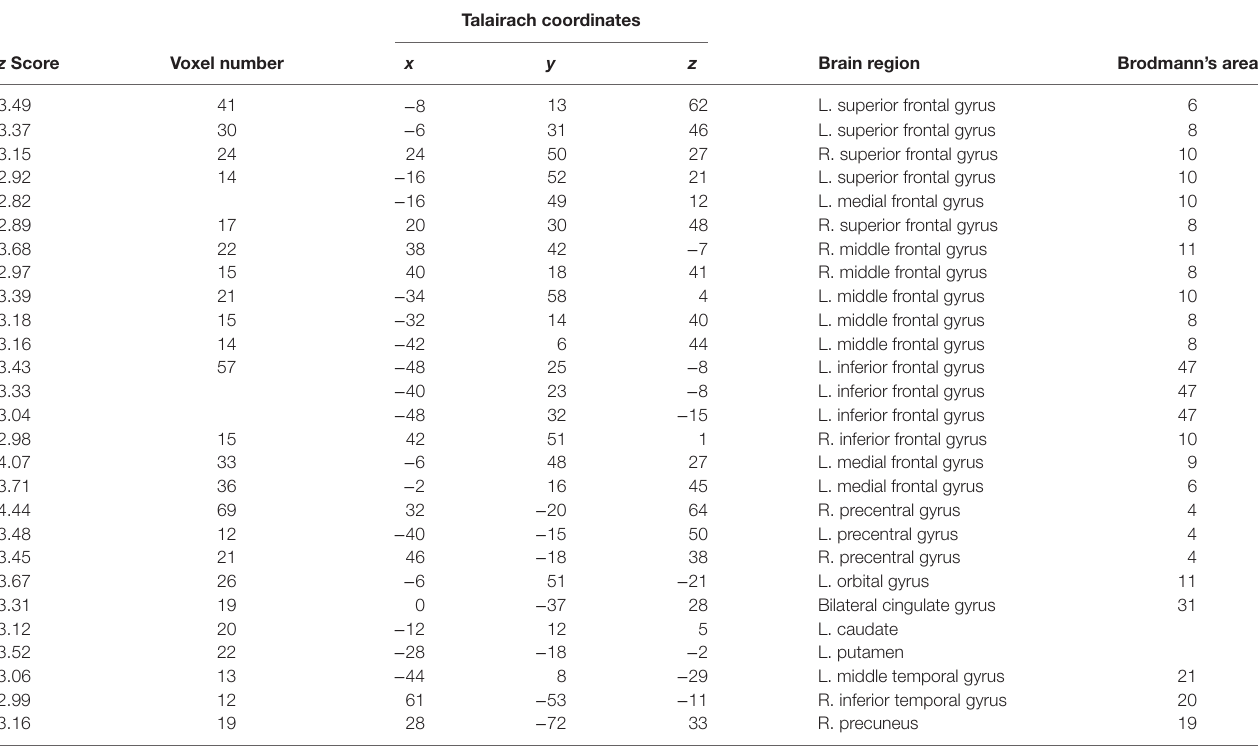
TaBle 3 | Areas of increased activation for traumatic slides and sounds after present-centered group therapy treatment. Talairach coordinates